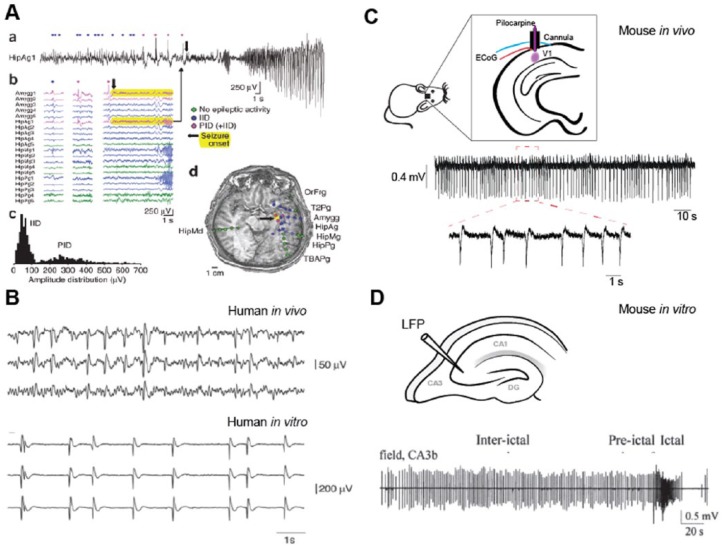
Interictal spikes. (A) Three main types of activity observed in a human
electroencephalography (EEG) recording. (a, b) Intracranial EEG traces
showing interictal discharges (IID, blue), pre-ictal discharges (PID,
pink) and ictal activity (yellow). (c) Amplitude distribution of IID and
PID. (d) Spatial localization of each recording electrode and associated
activity, showing a core of ictal activity (yellow spots) surrounded by
IIDs (blue spots). Modified from Huberfeld and others (2011).
(B) In vivo and in vitro recordings of interictal spikes in human mesial
temporal lobe. Modified from Cohen and others (2002). (C) In
vivo electrocorticogram (ECoG) recording of interictal spikes in a
pilocarpine neocortical focal epilepsy mouse model (unpublished data).
(D) In vitro local field potential (LFP) recording of interictal spikes
in hippocampal slices superfused with high K+ solutions.
Modified from Dzhala
and Staley (2003).